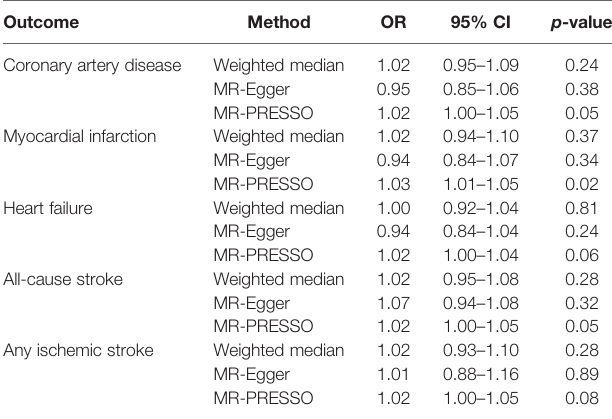
TABLE 2 | Sensitivity analyses of multiple sclerosis with cardiovascular diseases.